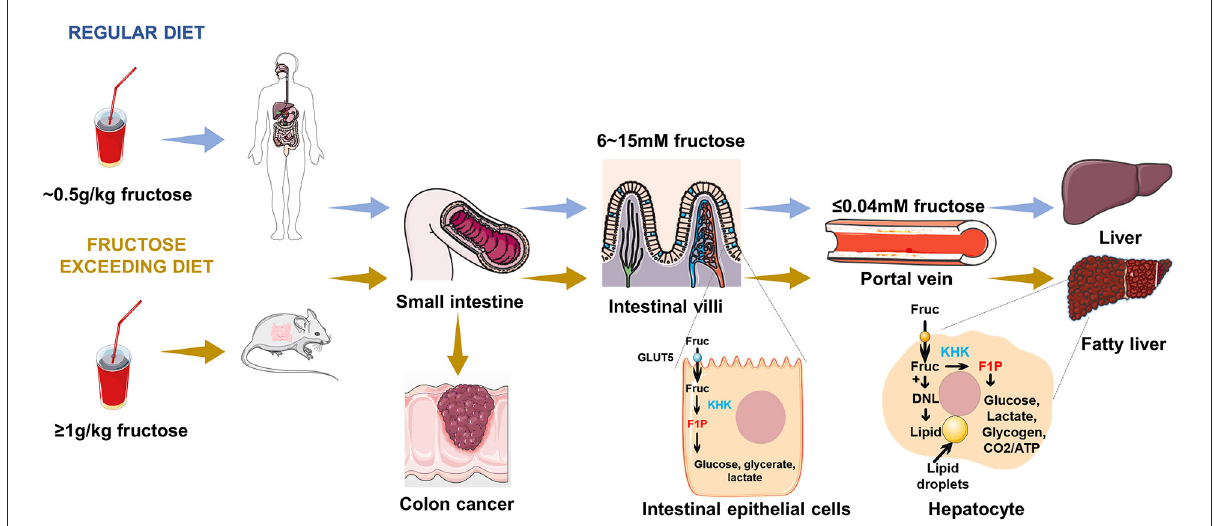
FIGURE1 Fructose metabolism in the gut and liver. Following ingestion of fructose, fructose is absorbed into intestinal epithelial enterocytes. Under fasting conditions, the fructose concentration in the small intestine is in the range of 6 ∼ 15mM, while fructose concentration in the portal vein is < 0.04mM. A portion of this fructose is phosphorylated by KHK within enterocyte and is converted to glucose, lactate, glycerate, and other organic acids, which transport from the portal vein to the liver. Fructose reaching the liver is efficiently extracted by hepatocytes and phosphorylated by KHK, where it can be used for glucose production, lipogenesis, glycogen synthesis, and energetic purposes. An excessive fructose diet can lead to colon cancer, fatty liver, and other related metabolic